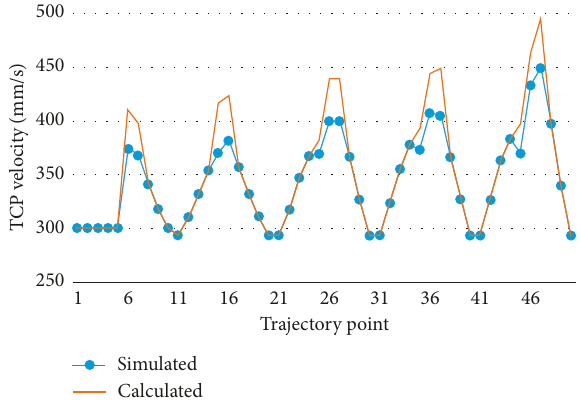
Figure 18: The simulated TCP velocity and the calculated TCP velocity for robot